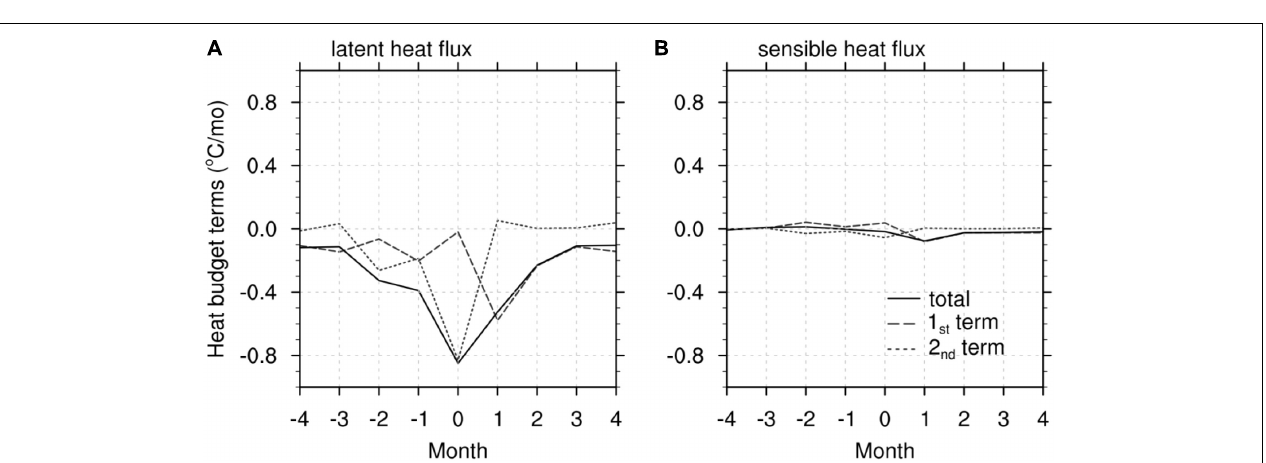
FIGURE 13 | Composites of monthly mean heat flux anomaly term in the mixed layer heat budget equation over the region (110 ◦ E-116 ◦ E, 22 ◦ S-32 ◦ S): (A) latent heat flux term, (B) sensible heat flux term.